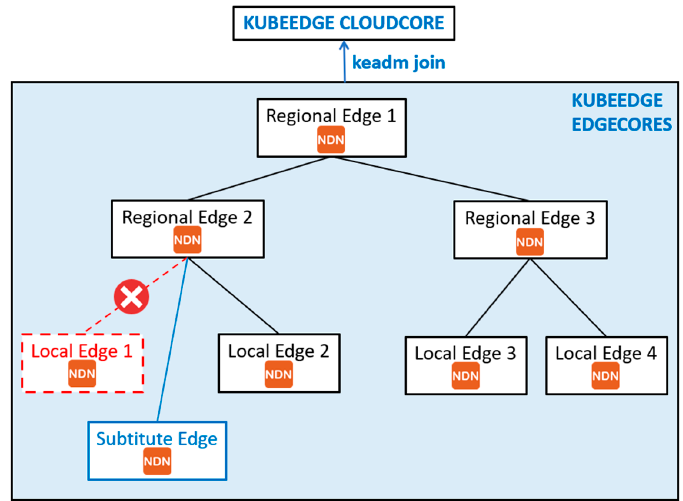
Figure 3. Named Data Networking (NDN) over KubeEdge general network architecture in single region.